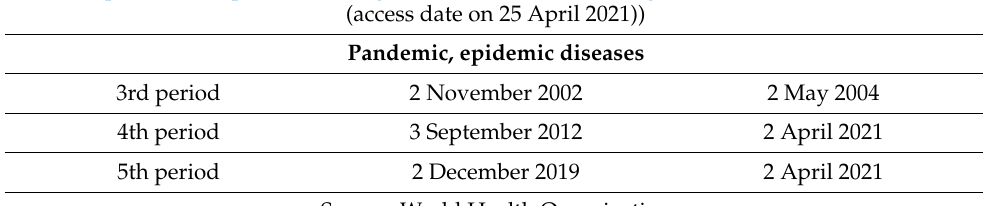
Table 1: U.S. Table 1: U.S. Recessions